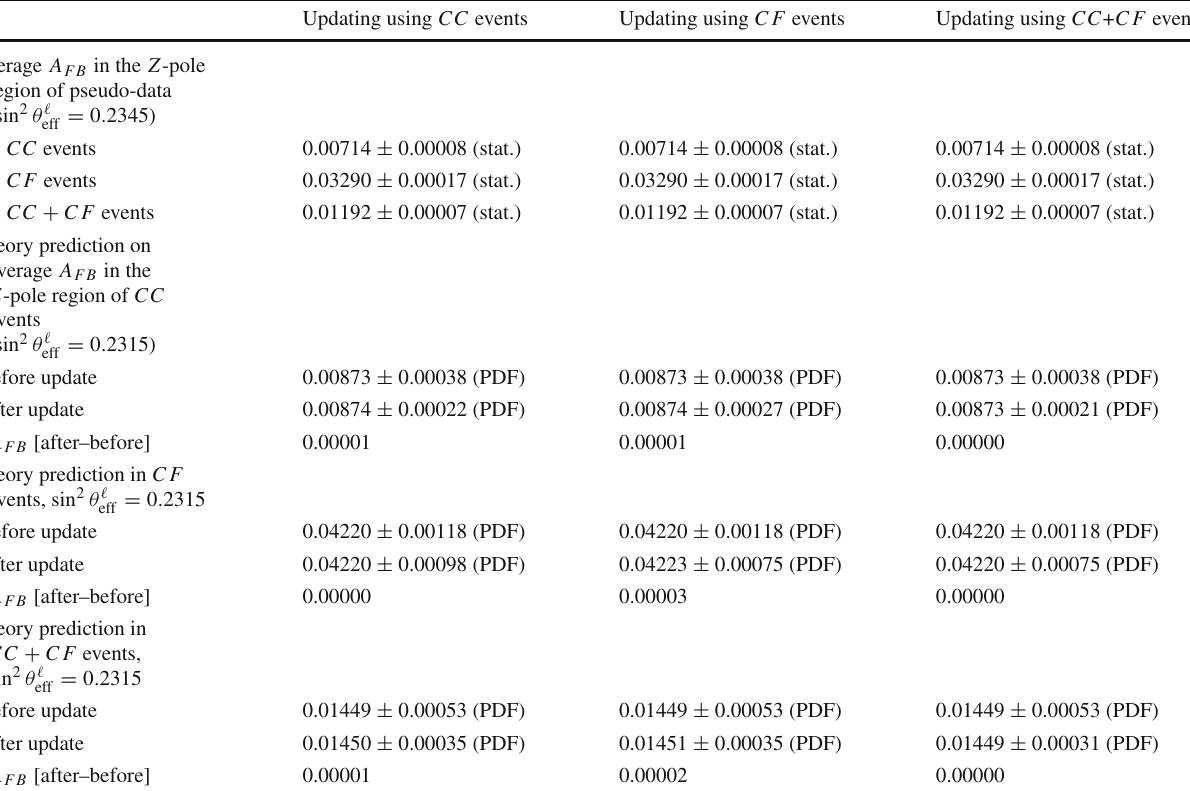
Table 1 Average A FB in the Z -pole region of the pseudo-data and theory predictions. The PDF updating is performed using the full mass range = 0 . 2345). Statistical uncertainty corresponds to the data sample with an integrated luminosity of 130 fb − 1 G (Δ) in pseudo-data (sin 2 θ (cid:4) eff